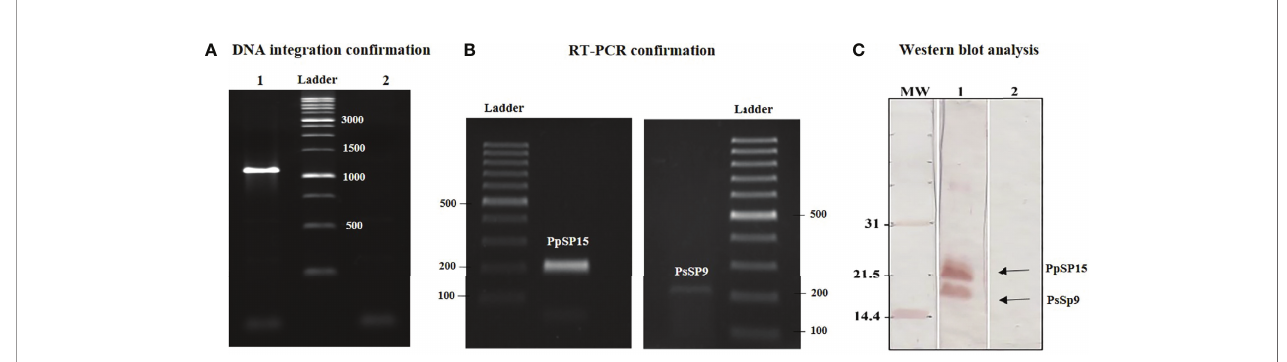
FIGURE 1 | Generation of recombinant parasite ( L. tarentolae PpSP15-T2A-PsSP9). (A) PCR ampli fi cation of the 1 kb band con fi rmed the integration of pLEXSY- PpSP15-T2A-PsSP9 into the parasite genome (lane 1). Lane 2 represents wild-type L. tarentolae as a negative control. (B) RT-PCR ampli fi cation of PpSP15 (left image) and PsSP9 (right image) con fi rmed recombination at the RNA level. (C) Western blot analysis for evaluating gene expression in recombinant L. tarentolae PpSP15-T2A-PsSP9. Lane 1 indicates proteins expression in recombinant L. tarentolae PpSP15-T2A-PsSP9. Lane 2 is wild-type L. tarentolae as a negative